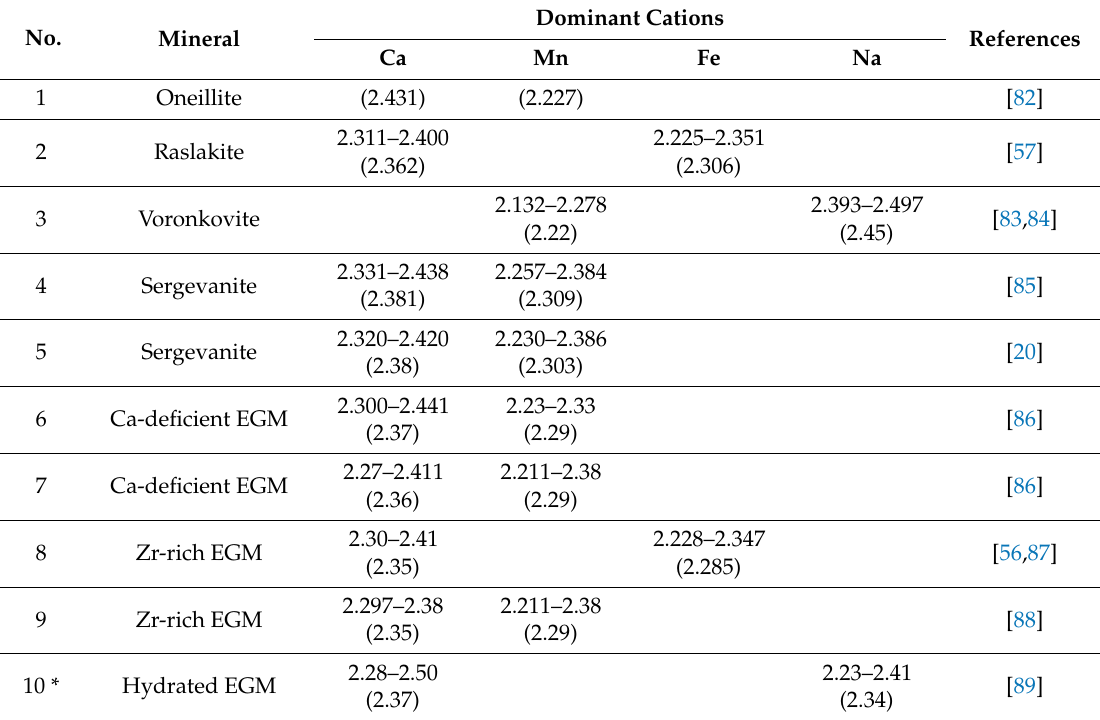
Table 5. Cation–oxygen distances (Å) in the M 1a- and M 1b-octahedra of ordered EGMs with the R 3 symmetry.